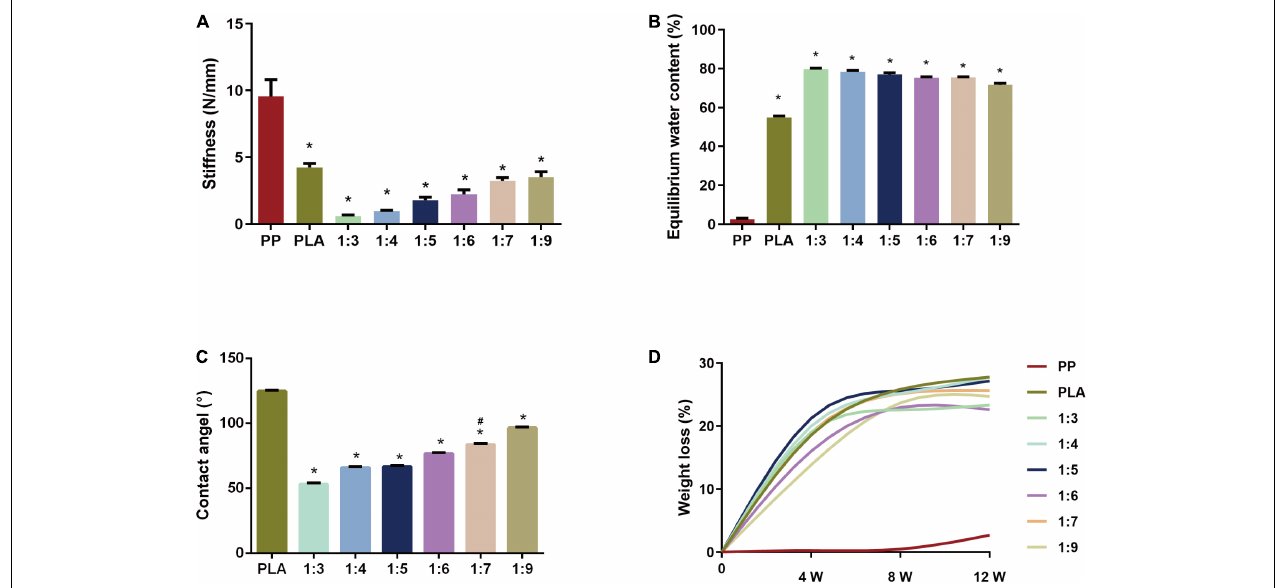
FIGURE 1 | Evaluation of characteristics of PNIPAAm-b-PEG/PLA biomimetic scaffolds. (A) Stiffness of scaffolds. * P < 0.05 vs. the PP group. (B) Equilibrium water content (EWC) at 37 ◦ C in PBS (pH 7.4). * P < 0.05 vs. the PP group. (C) Water contact angle of the electropsun scaffolds. * P < 0.05 vs. the PLA group, # P < 0.05 vs. the 1:9 group. (D) Degradation rate of scaffold samples.